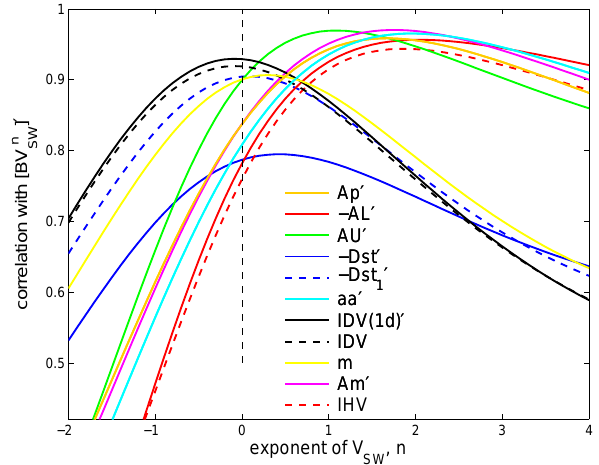
Fig. 1. Linear correlation coefficients of annual means of various geomagnetic indices with BV n , as a function of n , the exponent of the solar wind speed, V ( B is the IMF field strength). The primes denote the fact that data have been omitted in calculating either set of annual means if any of V , B or the geomagnetic index are miss- ing because of data gaps exceeding 1h duration. Values of BV n are computed hourly and then averaged. Table 2 gives the peak corre- lation r p , the n value giving peak correlation n p , and the signifi- cance of the peak correlation, S p . Correlograms are shown for AL (red line), AU (green line), − Dst (blue solid line), the negative part of Dst, − Dst1 (where Dst1 is the same as Dst but intervals when Dst > 0 are treated as data gaps) (blue dashed line), aa (cyan), Ap (orange), IDV (black dashed), Am (mauve), m (yellow), IHV (red dashed), and the IDV(1d) index described in Part 1 (black solid line). For indices which are increasingly negative for increasing ac- tivity (Dst, Dst1 and AL) the index has been multiplied by −